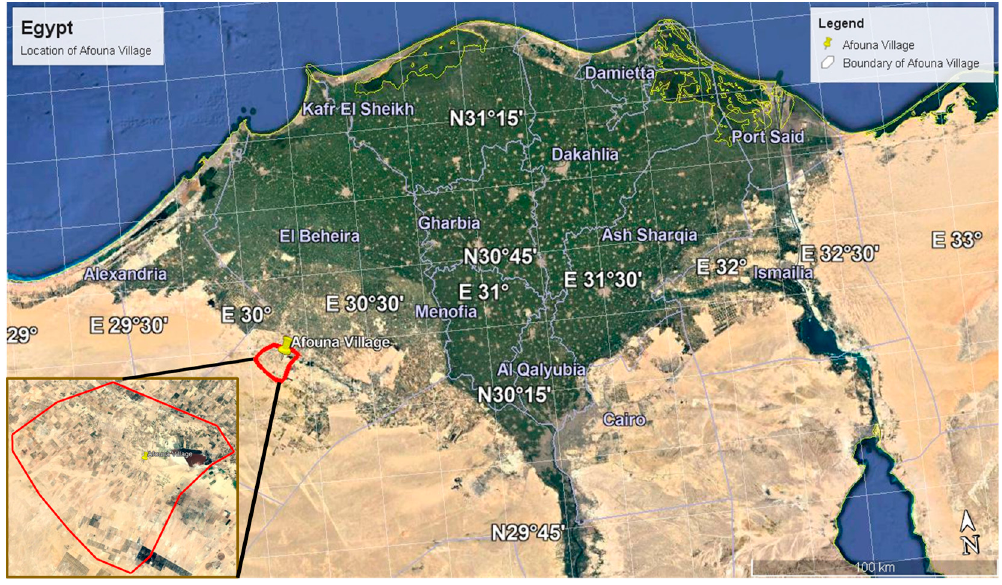
Figure 1. Location of Afouna Village.